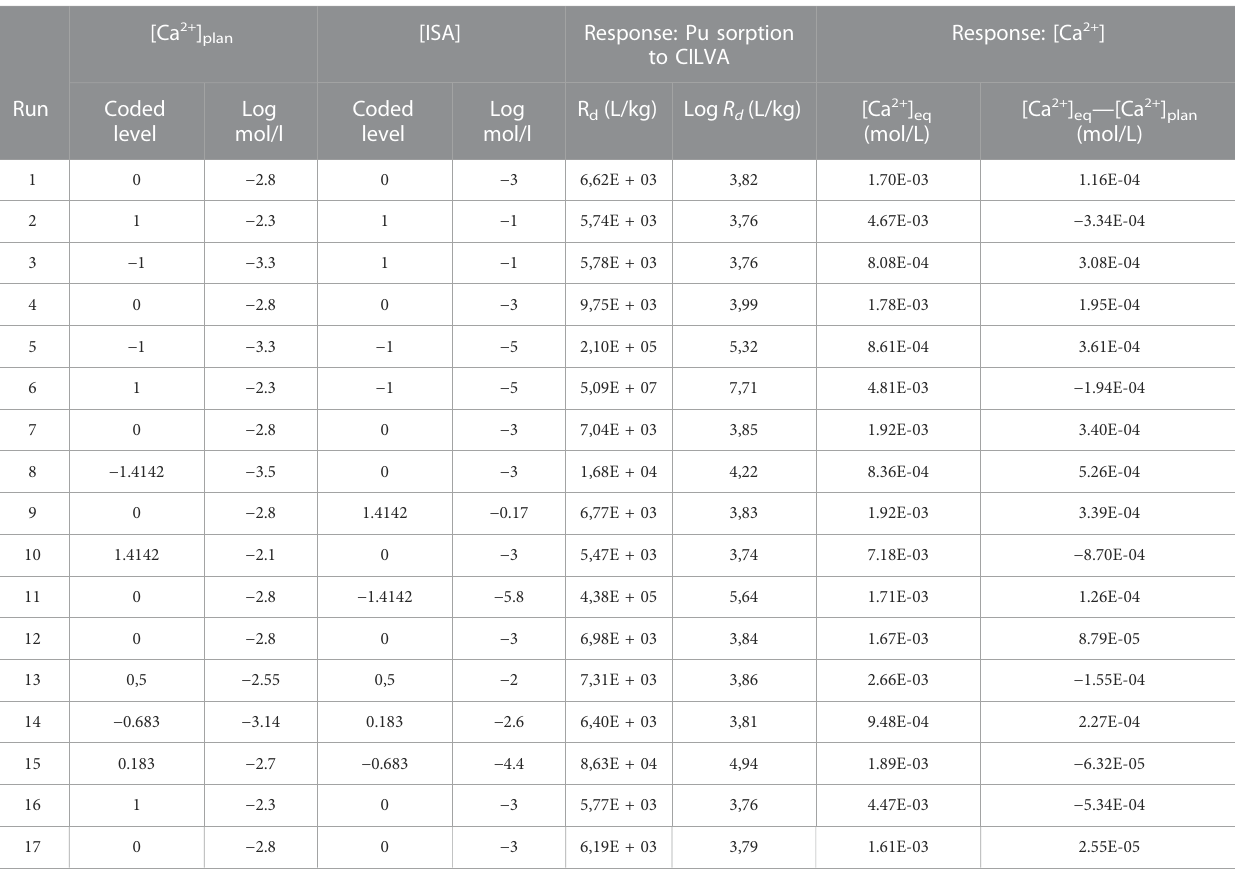
TABLE 7 Responses obtained for the 17 experiments, with [Ca 2+ ] and [ISA] levels indicated both as coded factor levels in log(M) and as molar concentrations. ResultsonPutotheCILVAmortarareprovidedas R d andlog R d .AsforCa 2+ ,the[Ca 2+ ]afterpre-equilibrationisprovided([Ca 2+ ] eq ),aswellasitsdifferencefromthe values foreseen in the experimental plan ([Ca 2+ ] eq — [Ca 2+ ] plan